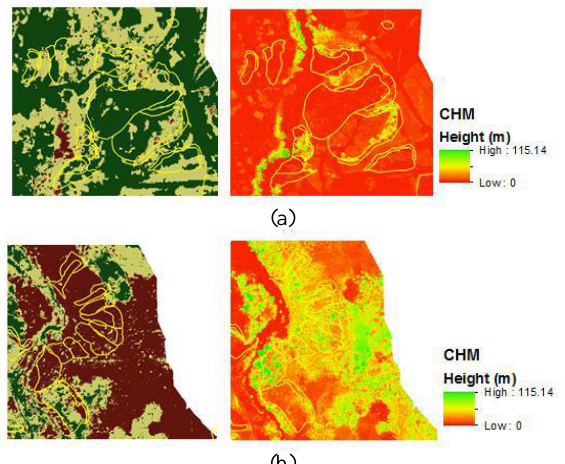
Figure 21. Landslide polygons located within (a) low probability of rotational dormant (b) high probability of rotational